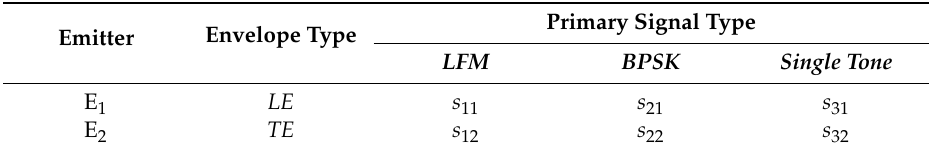
Table 1. The signal parameters used for di ff erent pulse envelopes. LE, linear envelope; TE, tangent envelope; LFM, linear frequency modulation; BPSK, binary phase shift